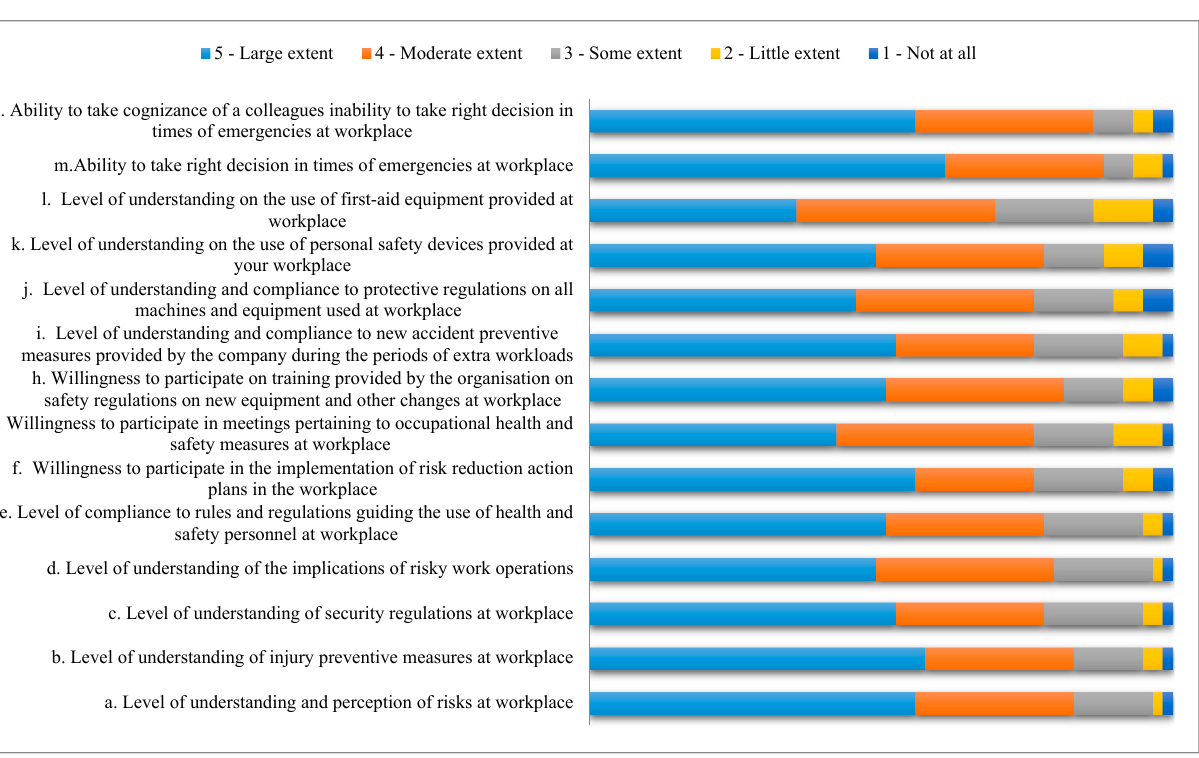
Figure 4. Frequency distribution (%) of the extent to which workers’ emotional intelligence affects their commitment to each of the key success factors of effective occupational health and safety management in the oil and gas industry.